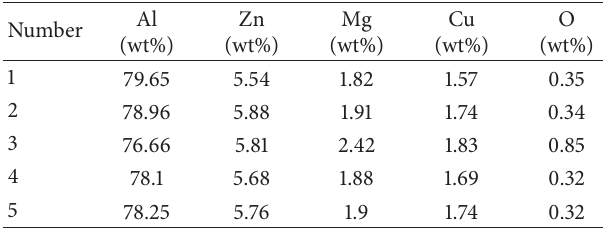
Table 2: Elemental analysis of Alumix 431D after T6 heat treatment from Figure